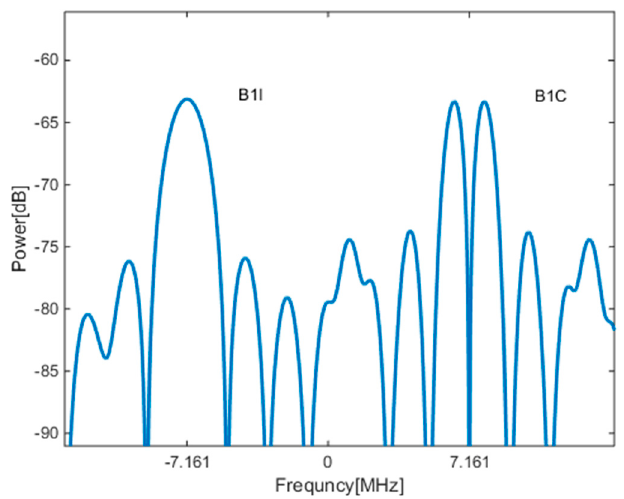
Figure 1. The power spectral density (PSD) of the B1-ADS signal.